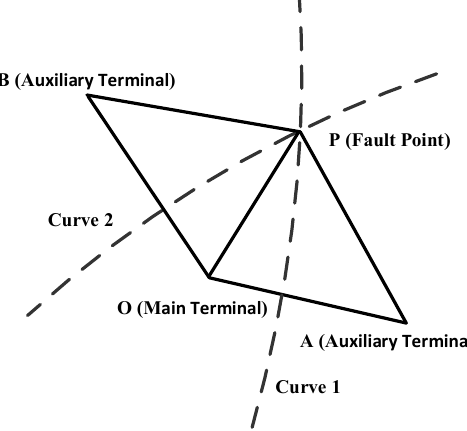
Fig.1. Schematic diagram of Location